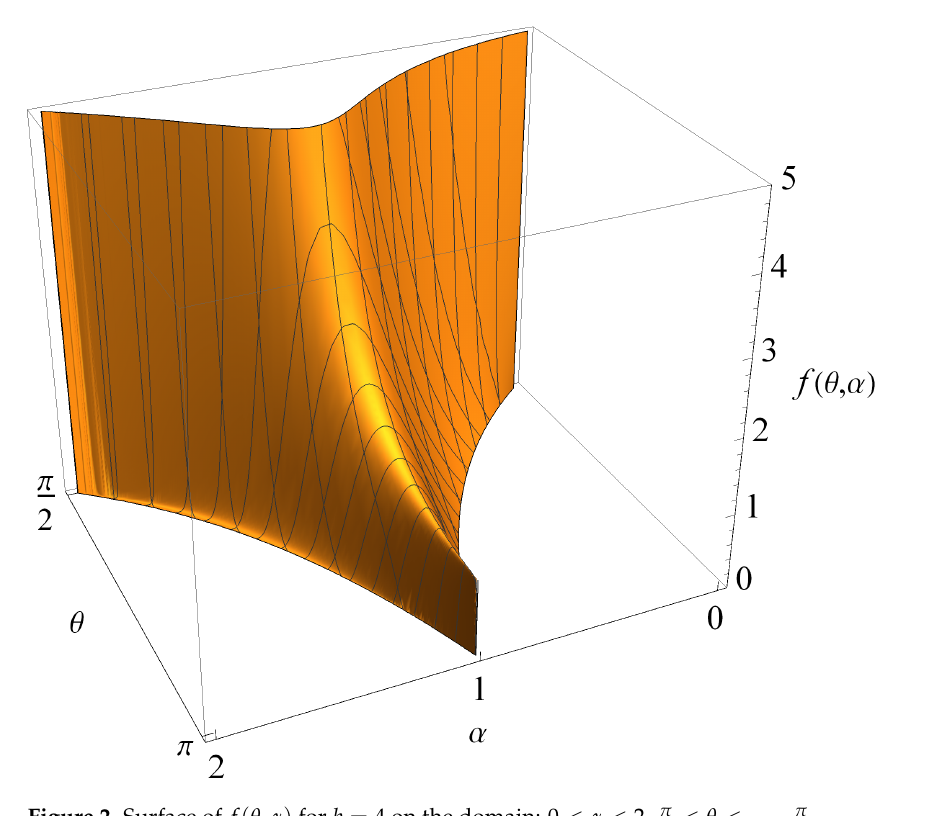
Figure 2. Surface of f ( θ , α ) for b = 4 on the domain: 0 < α < 2, π